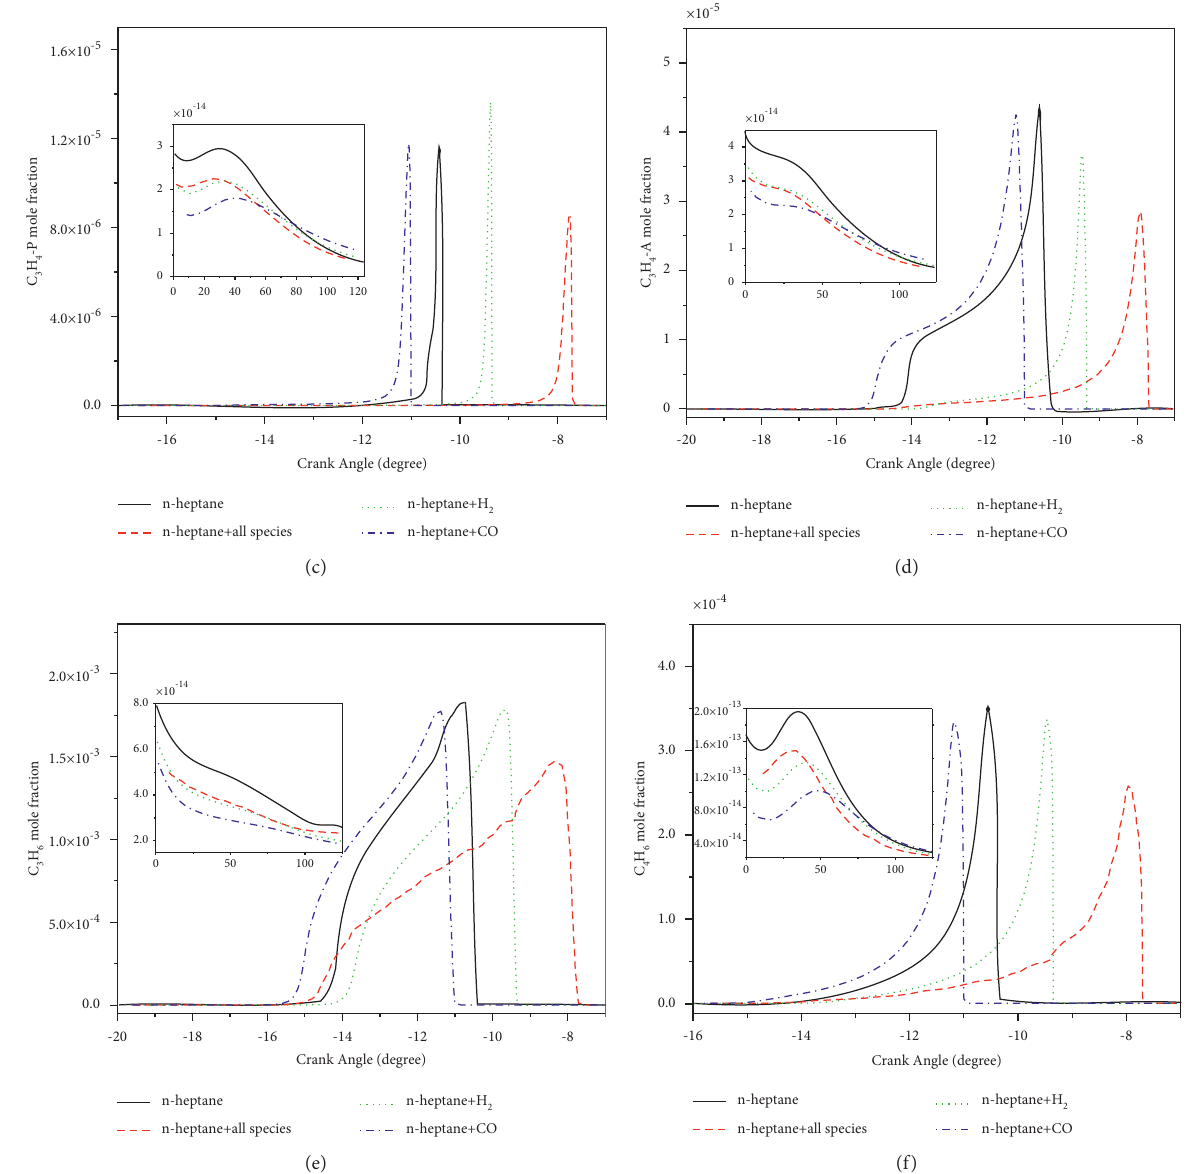
Figure 13: Distributions of hydrocarbons in different reforming mixtures in the normal